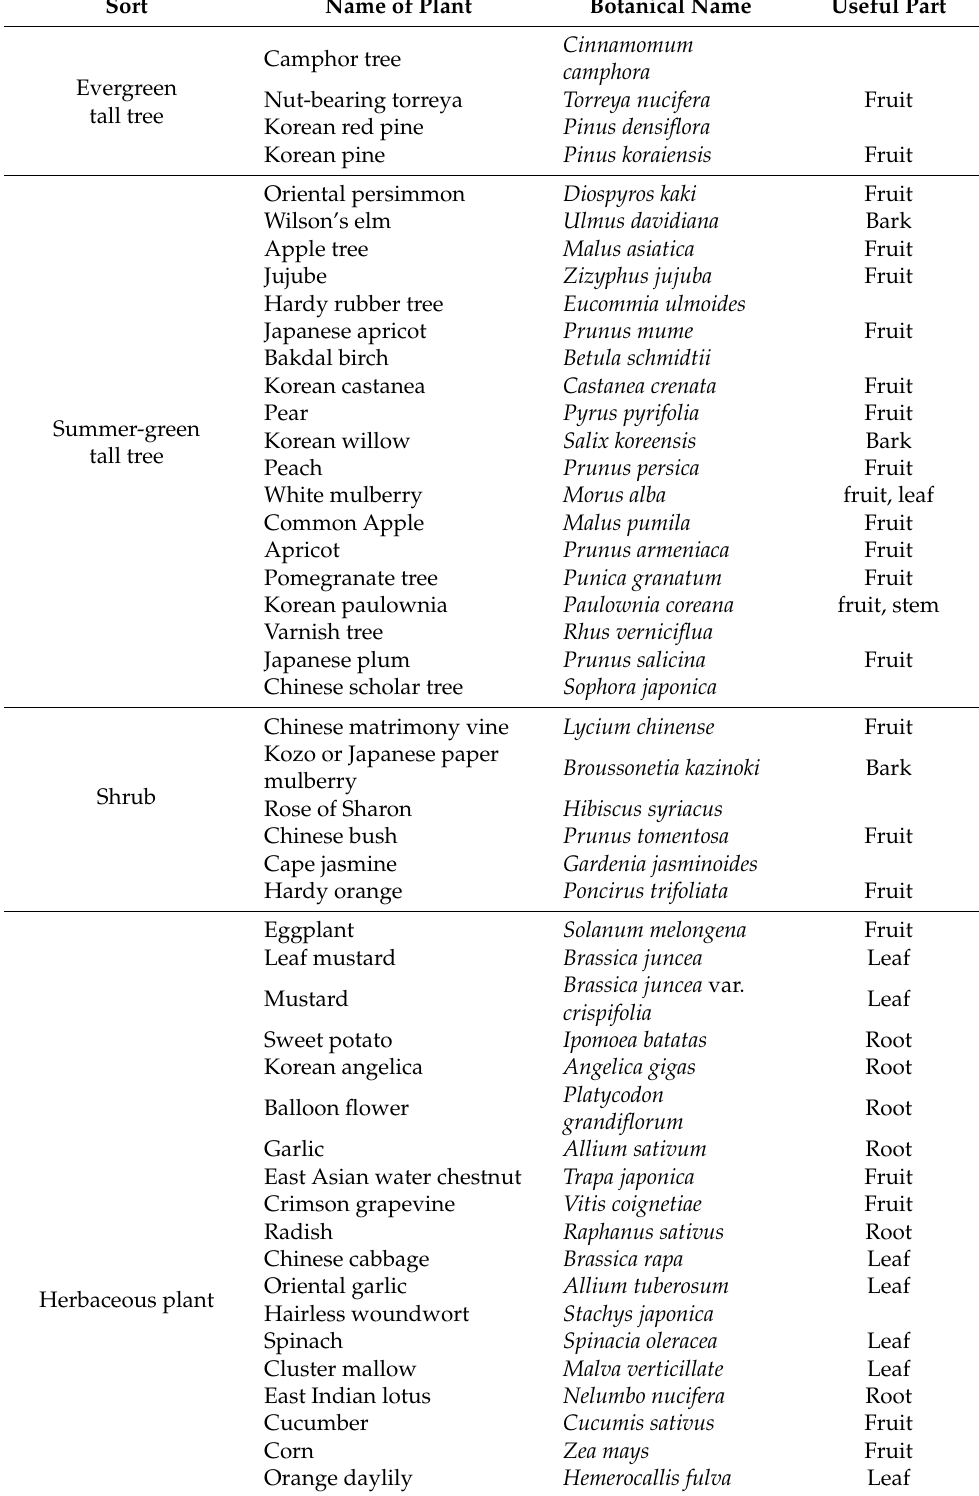
Table A1. Plants that appear in the imaginary